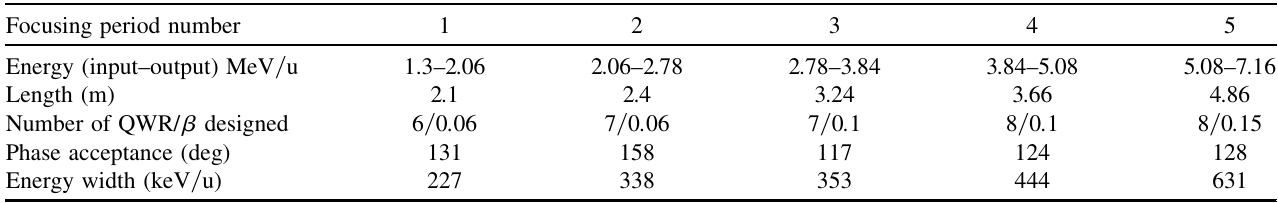
TABLE I. Final parameters for all five focusing periods.